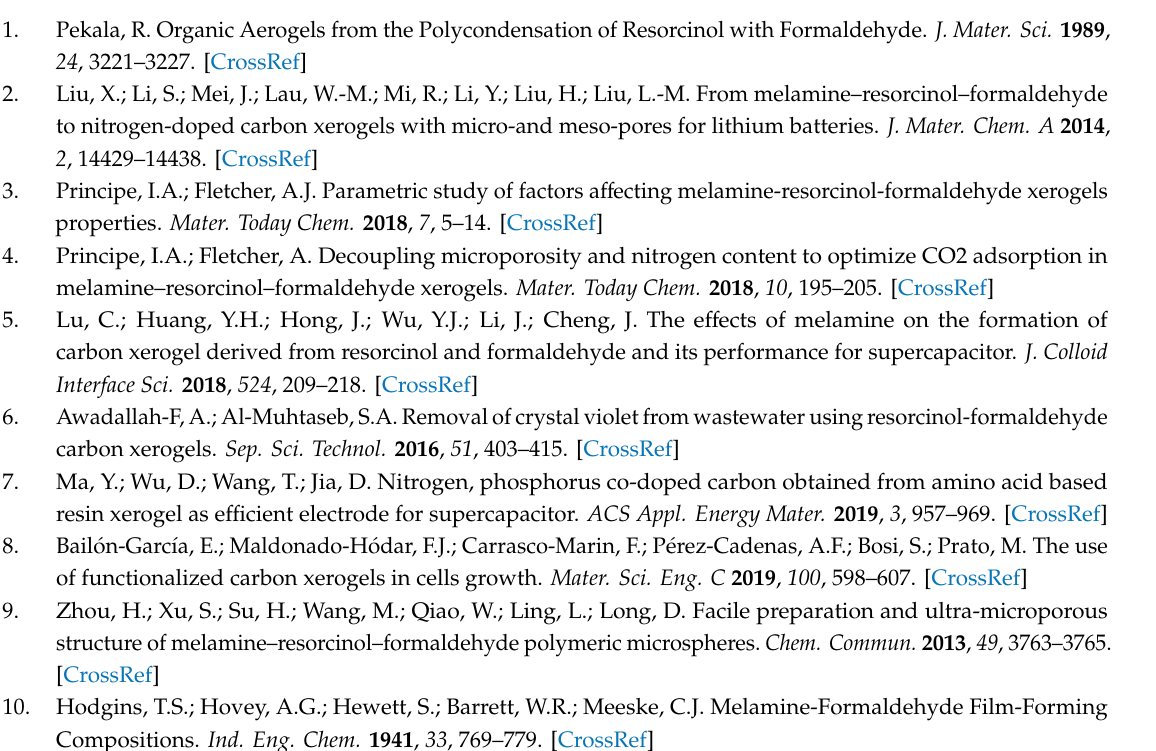
table as all values are reported to an accuracy less than the largest error for each